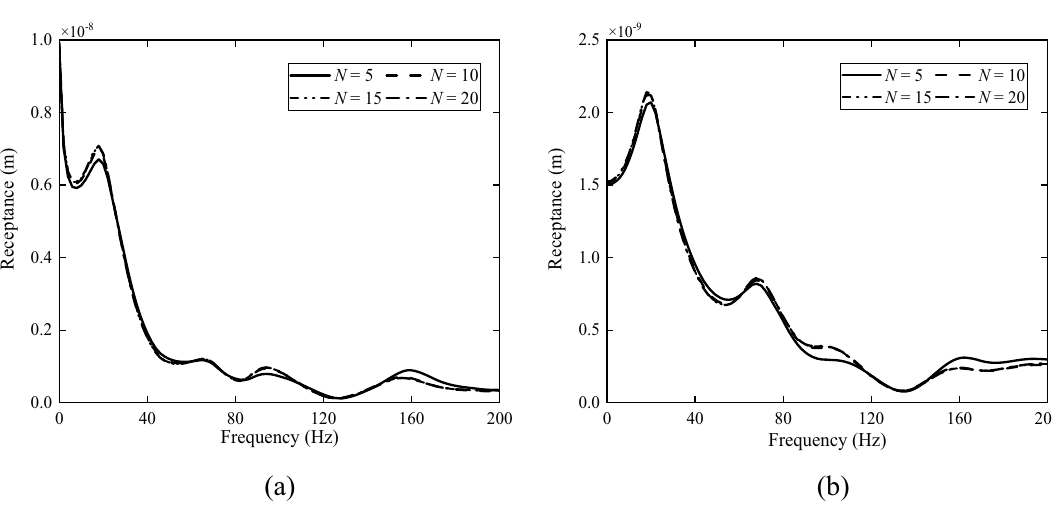
Figure 10. The vertical displacement of the ground surface at the centre of the loading area predicted for the third frozen ground with different layers. ( a ) Due to a vertical strip load; ( b ) due to a vertical circular